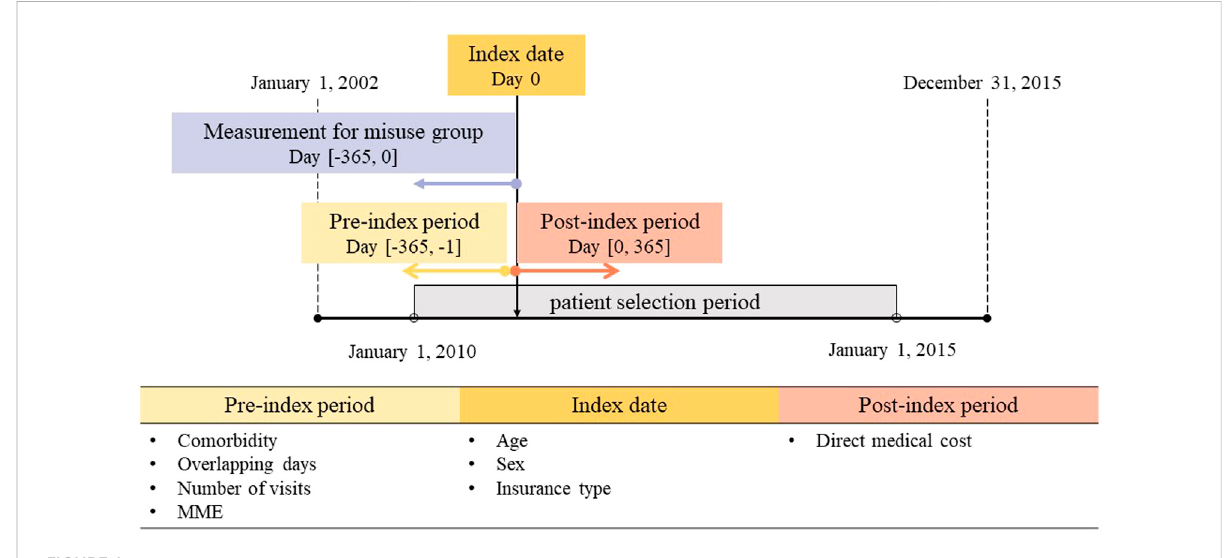
FIGURE 1 Study scheme. MME, morphine milligram